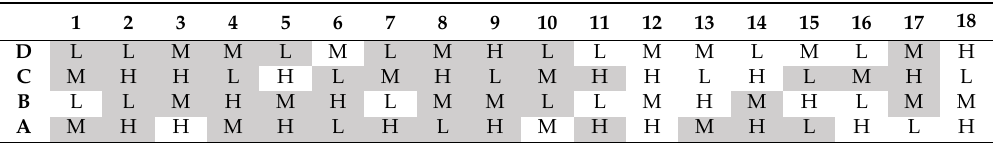
Table 1. Randomly distributed treatments on the experimental